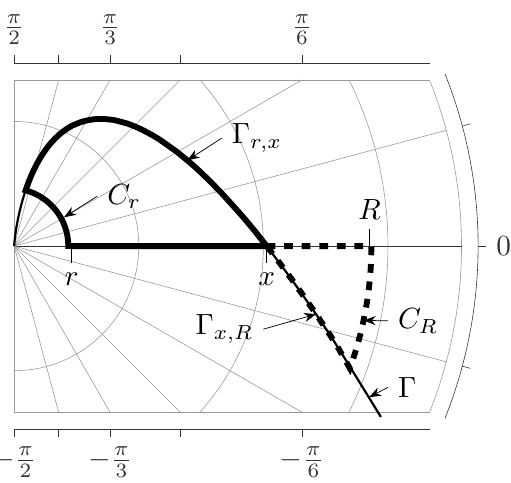
Figure 4. Auxiliary contours G r , x (heavy curve) and G x , R (dashed heavy